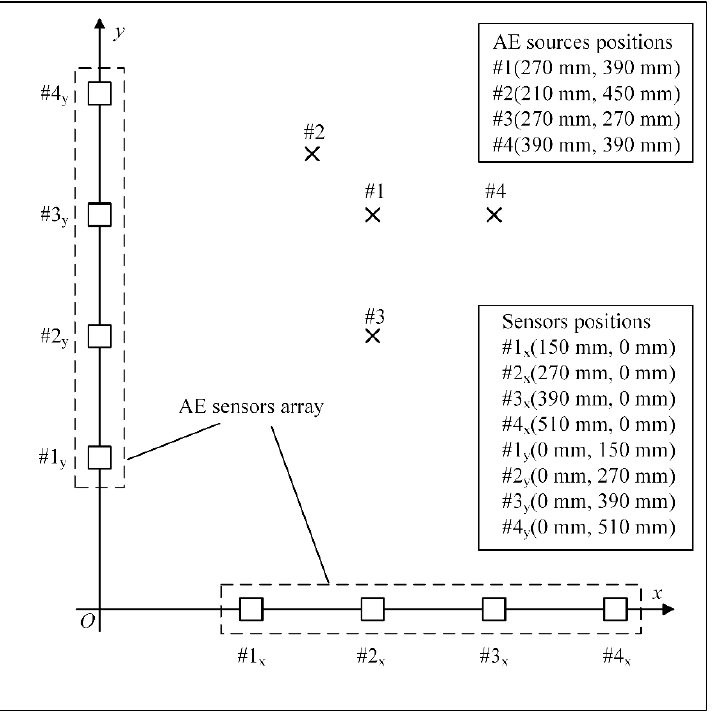
Figure 3. The arrangement of sensors and acoustic emission (AE) sources in the simulation.